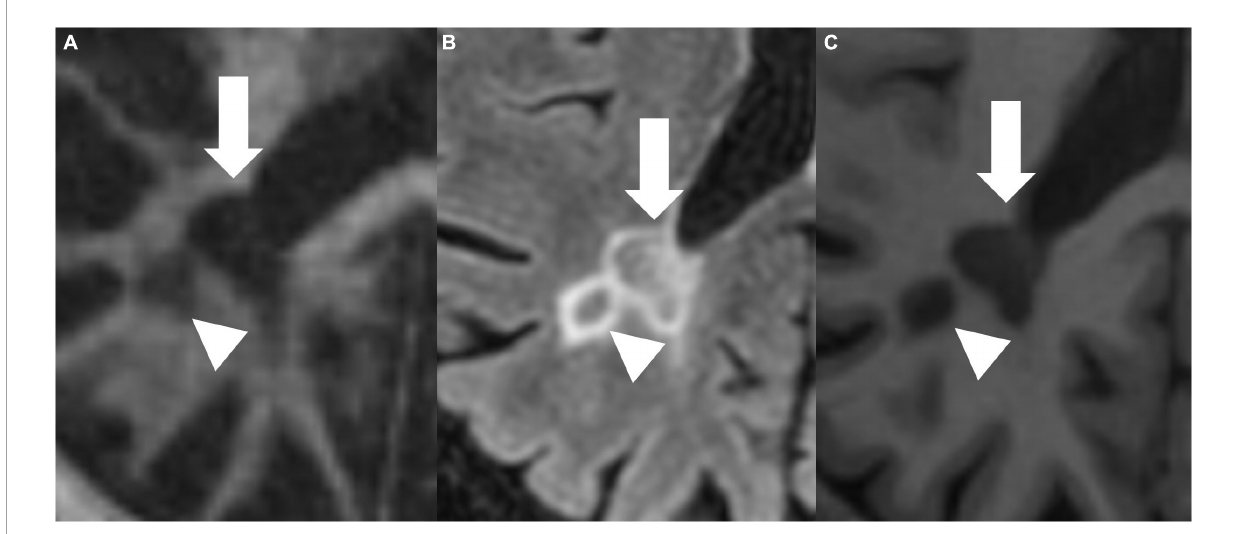
FIGURE5 IR-UTE (A) , FLAIR (B) , and MPRAGE (C) images show two periventricular MS lesions (white arrow and white arrowhead) next to each